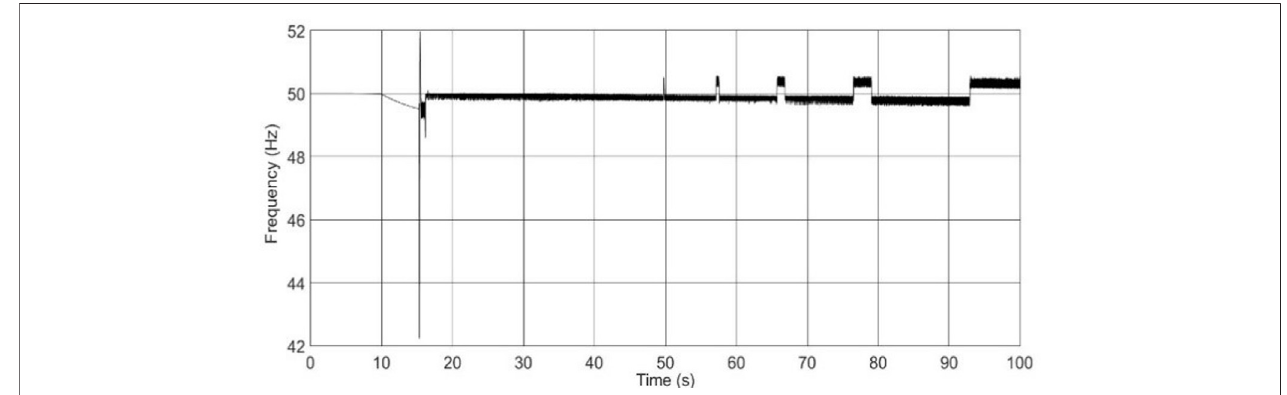
FIGURE 12 | Frequency fl uctuation of the voltage.